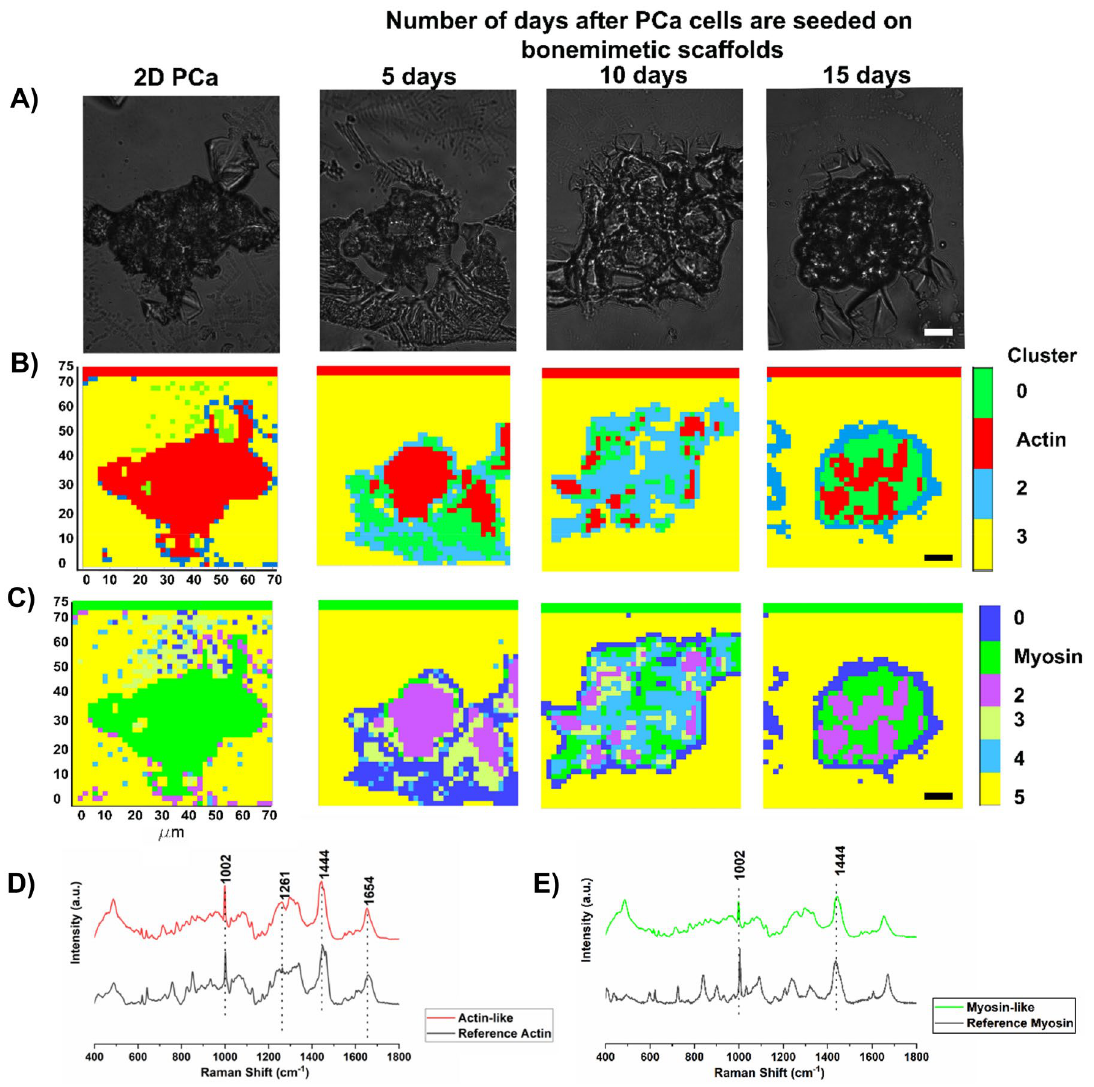
Figure 5. Cluster analysis of 2D PCa and PCa cells seeded on 3D bone-mimetic scaffolds for 5, 10, and 15 days. ( A ) optical images of samples used in Raman Imaging, ( B ) clusters indicating actin-rich regions colored in red, and the red stripe on the top of the image constitutes digitally introduced reference actin. ( C ) clusters indicating DNA rich regions colored in blue and the blue stripe on the top of the image constitutes digitally introduced reference DNA. Scale bars, 10 µm ( A – C ). ( D ) average spectra from ten randomly collected spectra from the actin-rich regions on day 15 and the reference spectra for actin, ( E ) average spectra from ten randomly collected spectra from the DNA rich regions on day 15 and the reference spectra for actin. The bone-mimetic scaffolds are created by seeding MSCs on 3D nanoclay based scaffolds and culturing for 23 days for the regeneration of bone tissue. PCa cells are seeded after the MSC culture period of 23 days is completed. The 2D PCa cells indicate PCa cells not seeded on